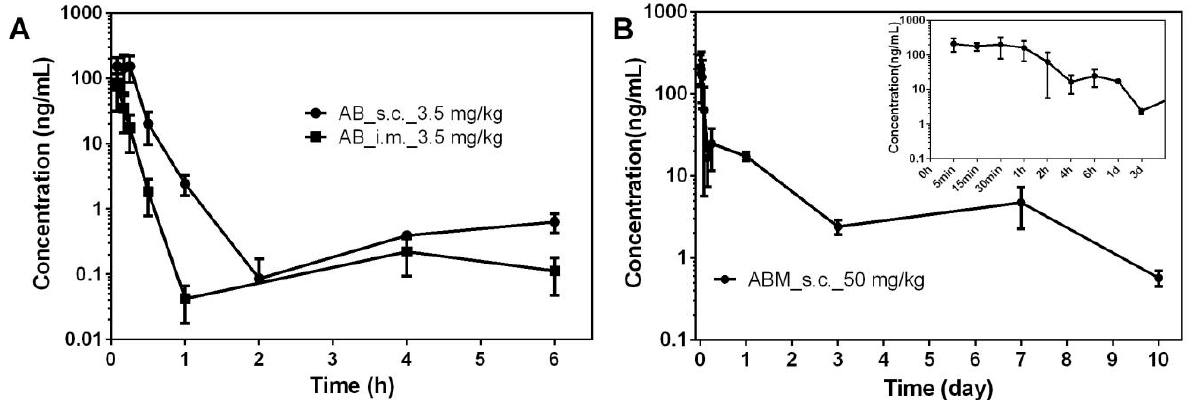
Figure 7. AB blood concentrations in male SD rats. ( A ) Comparison of PK results after intramuscular injection (IM) and subcutaneous injection (SC) of AB; ( B ) PK results of ABMs. All numerical results were denoted by mean and SD. Table 2. Pharmacokinetic data of AB and ABMs (Values represent mean ± SEM, n = 6).